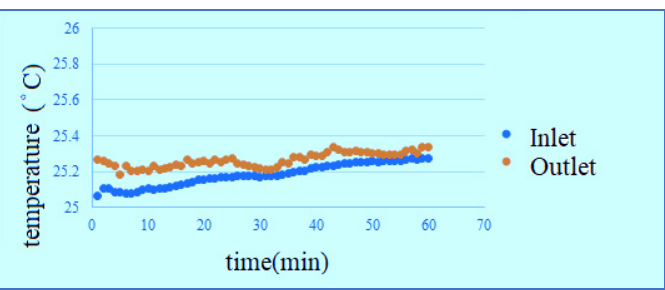
Figure 15. Low-temperature high-flow outlet/inlet temperature curve diagram.